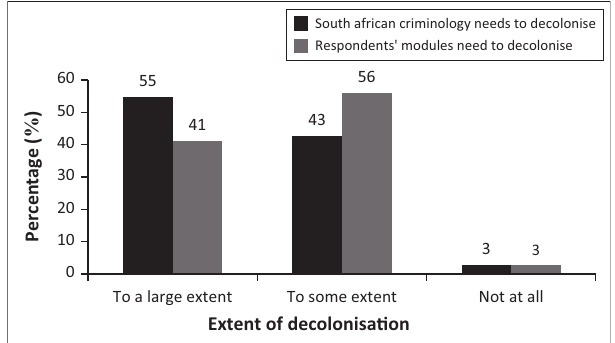
Figure 1: Should Criminology and its curriculum be decolonised? TABLE 4: Indigenous versus Eurocentric perspectives in Criminology curriculum (postgraduate student responses) Curriculum